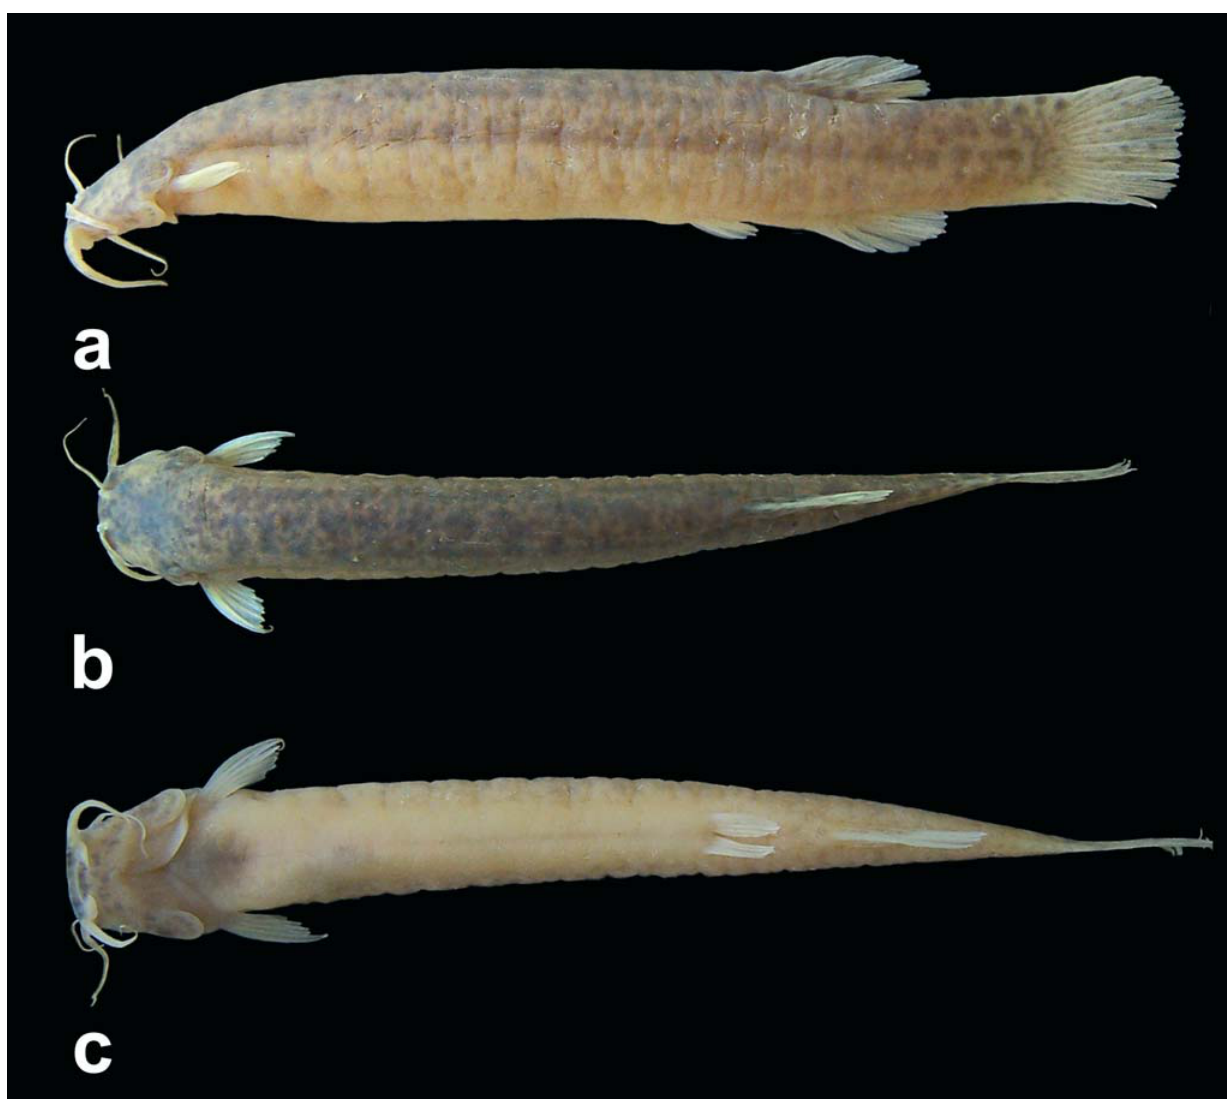
Fig. 1. Ituglanis cahyensis , holotype, MNRJ 28404, 48.6 mm SL. Rio Palmares on the road Guarany-Corumbau, Prado, Bahia, Brazil. a. lateral; b. dorsal; c. ventral and by the color pattern with rows of dark blotches ( vs. scat- tered small spots). From I. gracilior by the higher number of ribs, four ( vs. two or three), by the low vertebral count, 40 ( vs. 41-43), by the supraorbital laterosensory canal lacking pore s1 ( vs. s1 pore present), and by the color pattern with longitu- dinal rows of coalescing blotches ( vs. scattered spots). From I. guayaberensis by the color pattern with longitudinal rows of coalescing blotches ( vs. scattered dark brown spots). From I. herberti by the supraorbital laterosensory canal lacking pore s1 ( vs. s1 pore present), and by the color pattern with longitudinal rows of coalescing blotches ( vs. faint light brown spots). From I. laticeps by the pectoral fin ray counts i,4 ( vs. i,6), by the branched caudal fin rays 5/5 or 5/6 ( vs. 6/7), by the high vertebral count, 40 ( vs. 37) and by the color pattern with